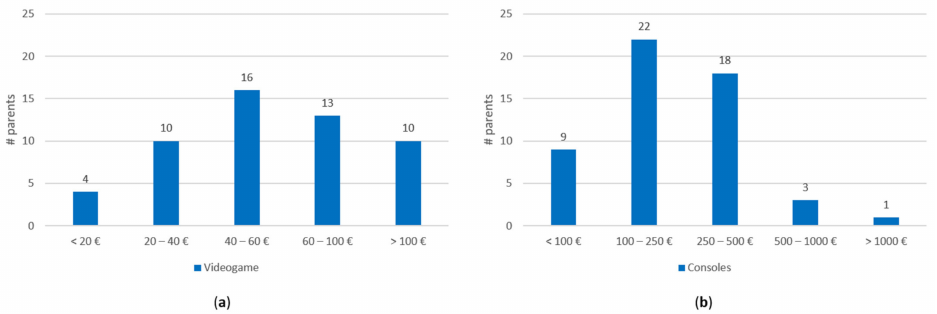
Figure 10. Price categories that parents would afford for videogames ( a ) and consoles ( b ) specifically designed for children with neurological